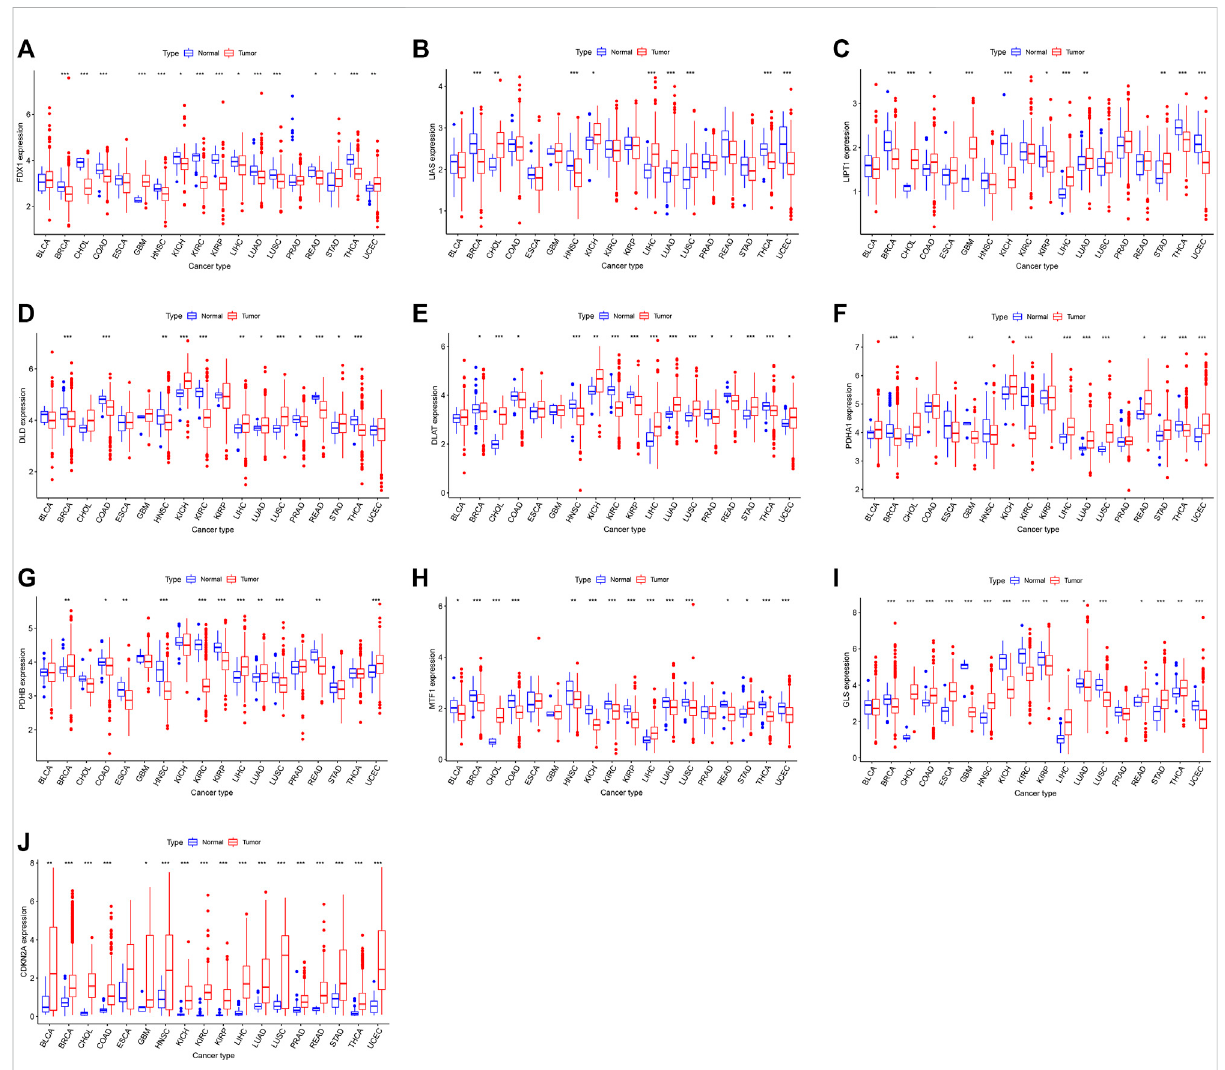
FIGURE 3 (A – J) The levels of cuproptosis-associated genes in various tumor and normal tissues. The blue box plot indicates normal tissue. The red box plot indicates tumor tissue. * p < 0.05, ** p < 0.01, and *** p <